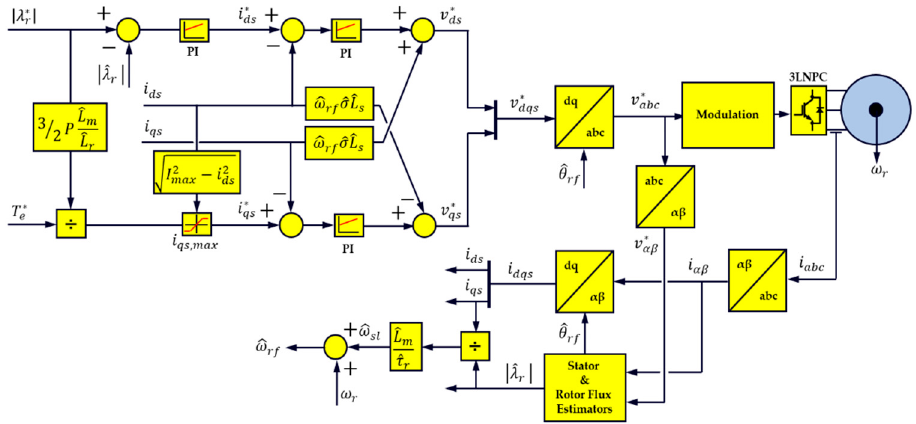
9 of 22 Figure 8. Closed loop V/F with torque/flux control and feedforward (CLVFC&FF) scheme. 3.2. Vector-Based Control Vector control methods are aimed at directly manipulating the IM fields and torque. These methods are based on well-known d-q models. Field-Oriented Control (FOC) represents flux and